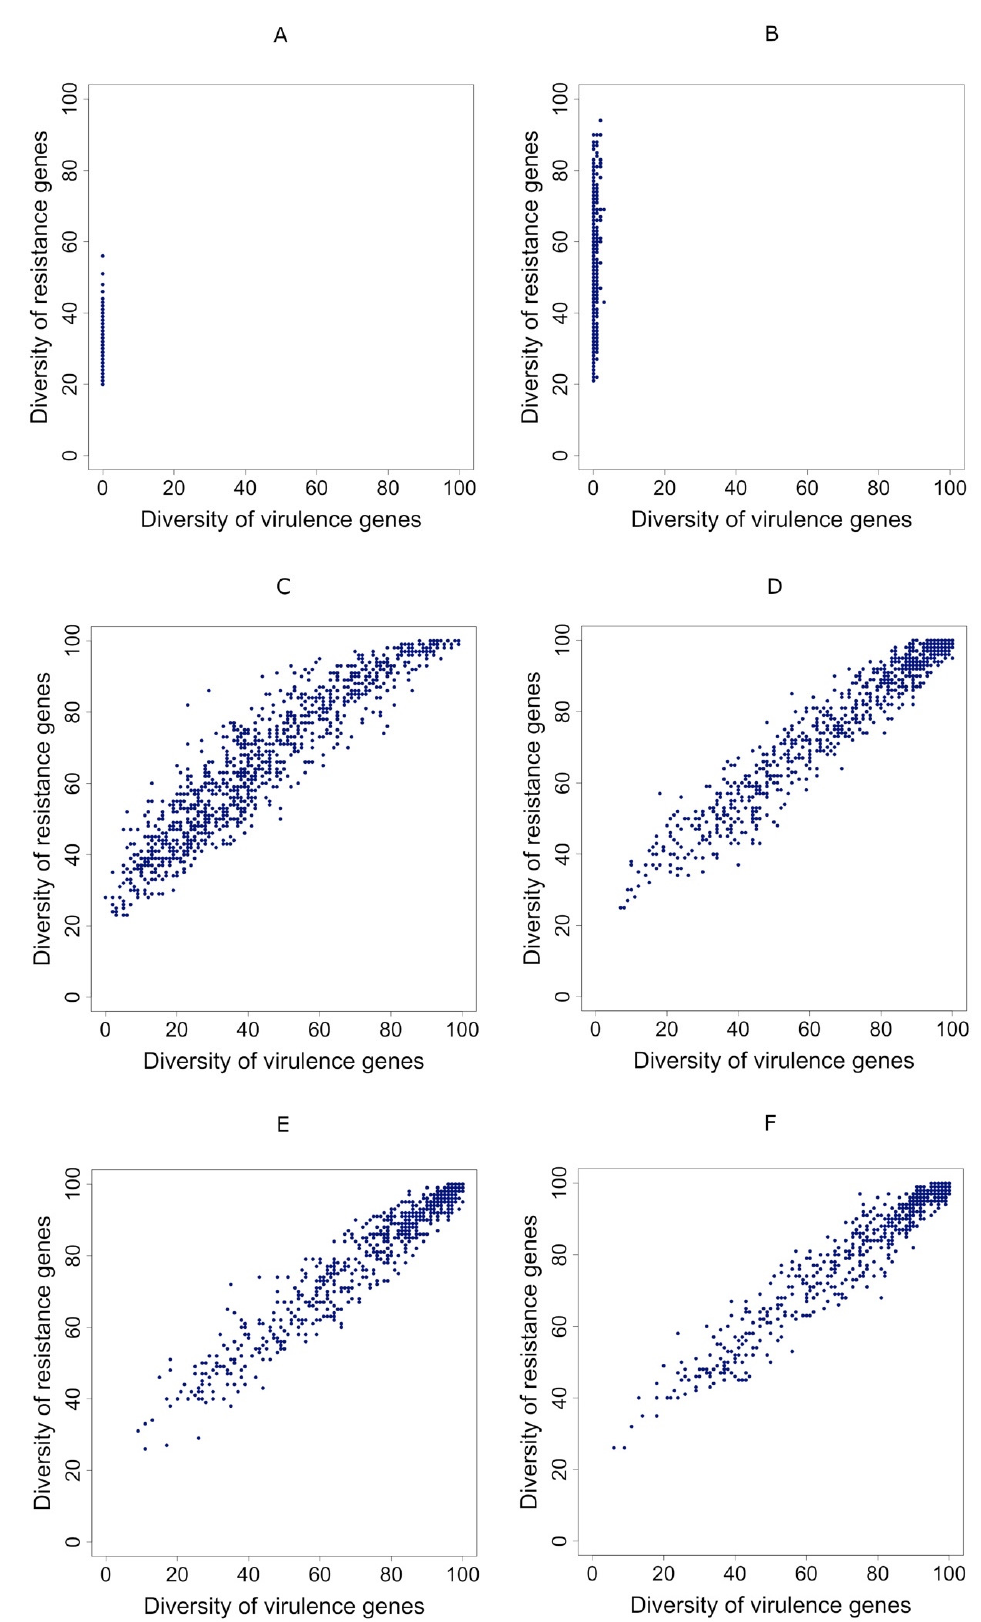
Figure 3. Effect of the gene transmission probability. ( A – F ): the relationship between the diversity of resistance genes (vertical axes) and the diversity of virulence genes (horizontal axes). Each dot represents the case of an individual